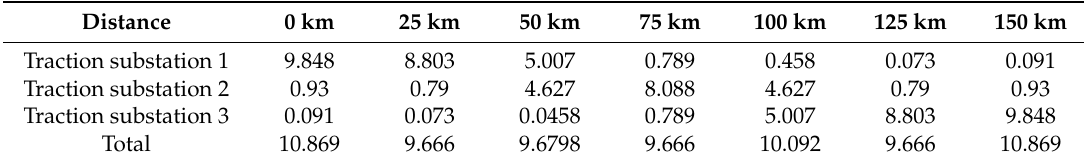
Table 4. The output power of traction substations.